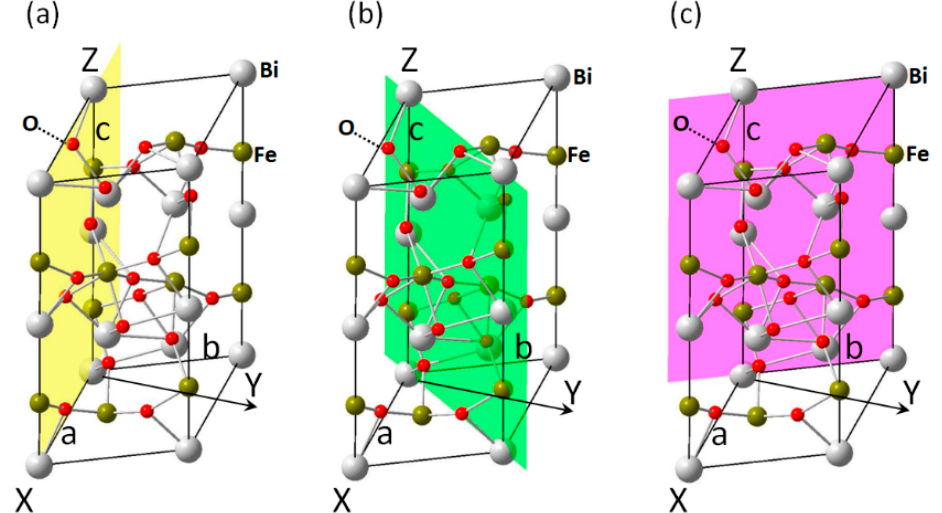
Figure 8. Crystalline planes of BiFeO 3 at various rotation angles: ( a ) φ = 0 ◦ , along a - and c -axes, Miller - index (010)-plane; ( b ) φ = 60 ◦ , along c -axis, Miller index (1(-)10)-plane; ( c ) φ = 120 ◦ , along b - and c -axes, Miller index (100)-plane. The three planes are also the three mirror symmetry planes.